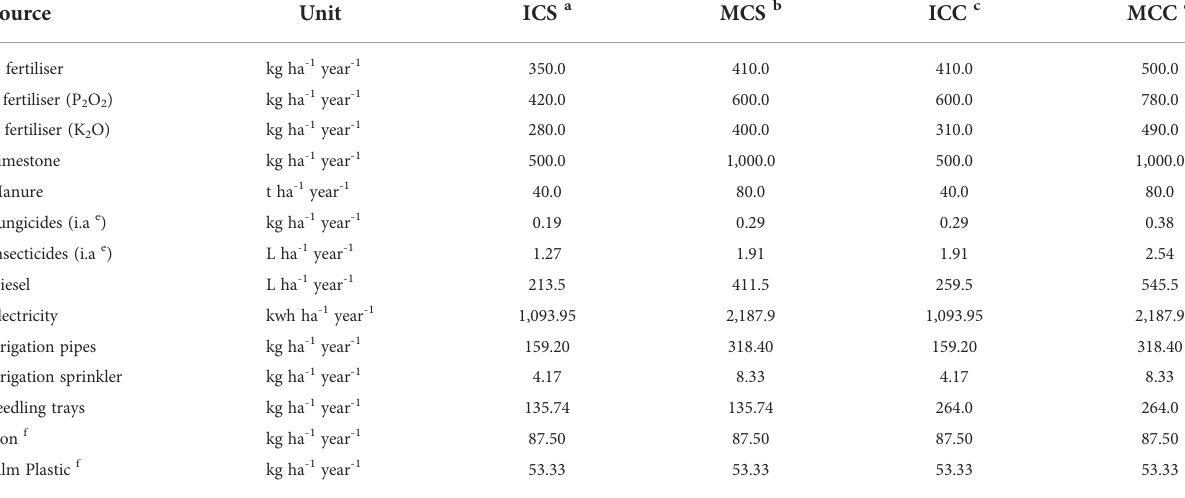
TABLE 1 Amount of inputs and materials used for one year of production of collard greens (1 cycle per year), New Zealand spinach (2 cycles per year) and chicory (3 cycles per year) in intercropping and monoculture